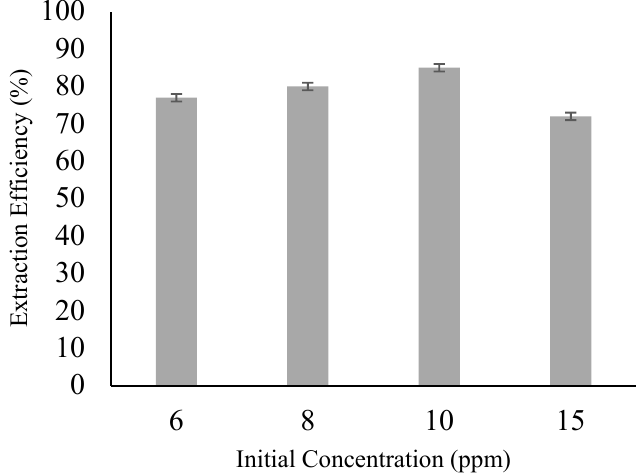
Figure 6. E ff ect of HCl concentration (Experimental condition: [Ammonia] = 0.1 M; [TOA] = 6 wt%; [Span 80] = 6 wt%; [HCl] = 0.1 M; Volume Ratio = 3:1; Stripping Agent = Ammonia; Diluent = Kerosene) .